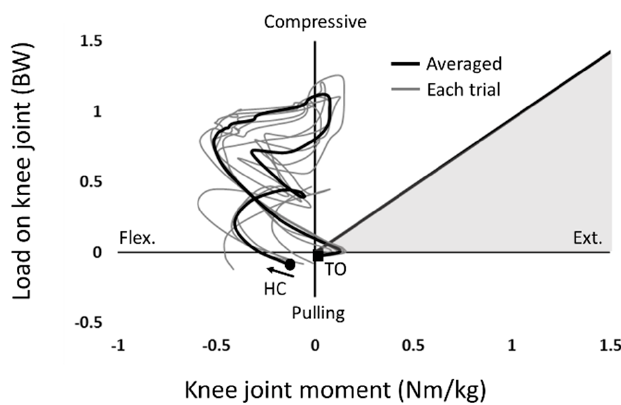
Figure 9. Relationship between the moment and the load on the prosthetic knee in the stance phase. Positive and negative values in the moment indicate extension (Ext.) and flexion moments (Flex.). Positive and negative values in the force indicate compressive and pulling forces, respectively. ● is the heel contact (HC), and ■ is the toe off (TO).